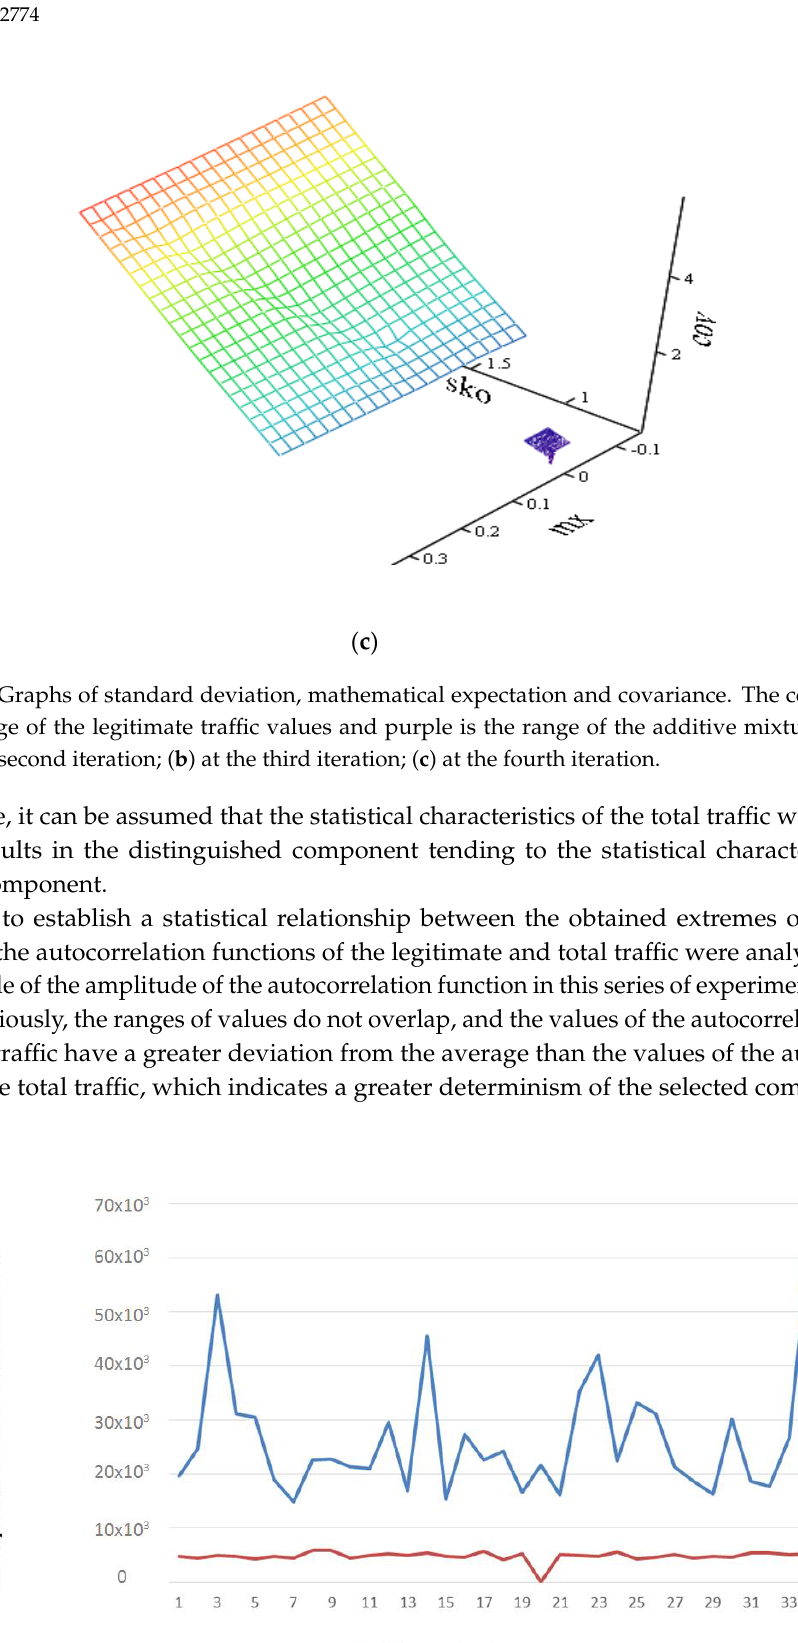
Figure 8. The correlation interval of the autocorrelation function of the legitimate traffic components (blue color) and the total traffic components (red color) at the third iteration. When adding an additional component to legitimate traffic, the rate of change of the process should increase. This will be more obvious with decomposition. The ranges of the correlation interval also do not overlap, and the sample of legitimate traffic values (blue) has a more pulsating character, while the values of the total traffic are smoother. The correlation interval of the total traffic at the third and fourth iterations is always much less than the correlation interval of the legitimate traffic. That is, the rate of change of the extracted component from the total traffic is higher than the rate of change of the extracted component from the legitimate traffic. It is important for signaling the presence of an attacker to be sufficient, but not redundant. In order to make a decision about the presence of unauthorized actions on the network, the changes in the statistical parameters of the total and legitimate traffic at several iterations should be considered, and take the second iteration and two subsequent iterations, which have the most distinguishable characteristics.